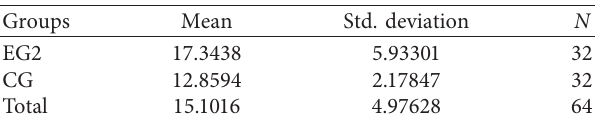
Table 4: Descriptive statistics for comparing the posttest scores of the EG2 and CG